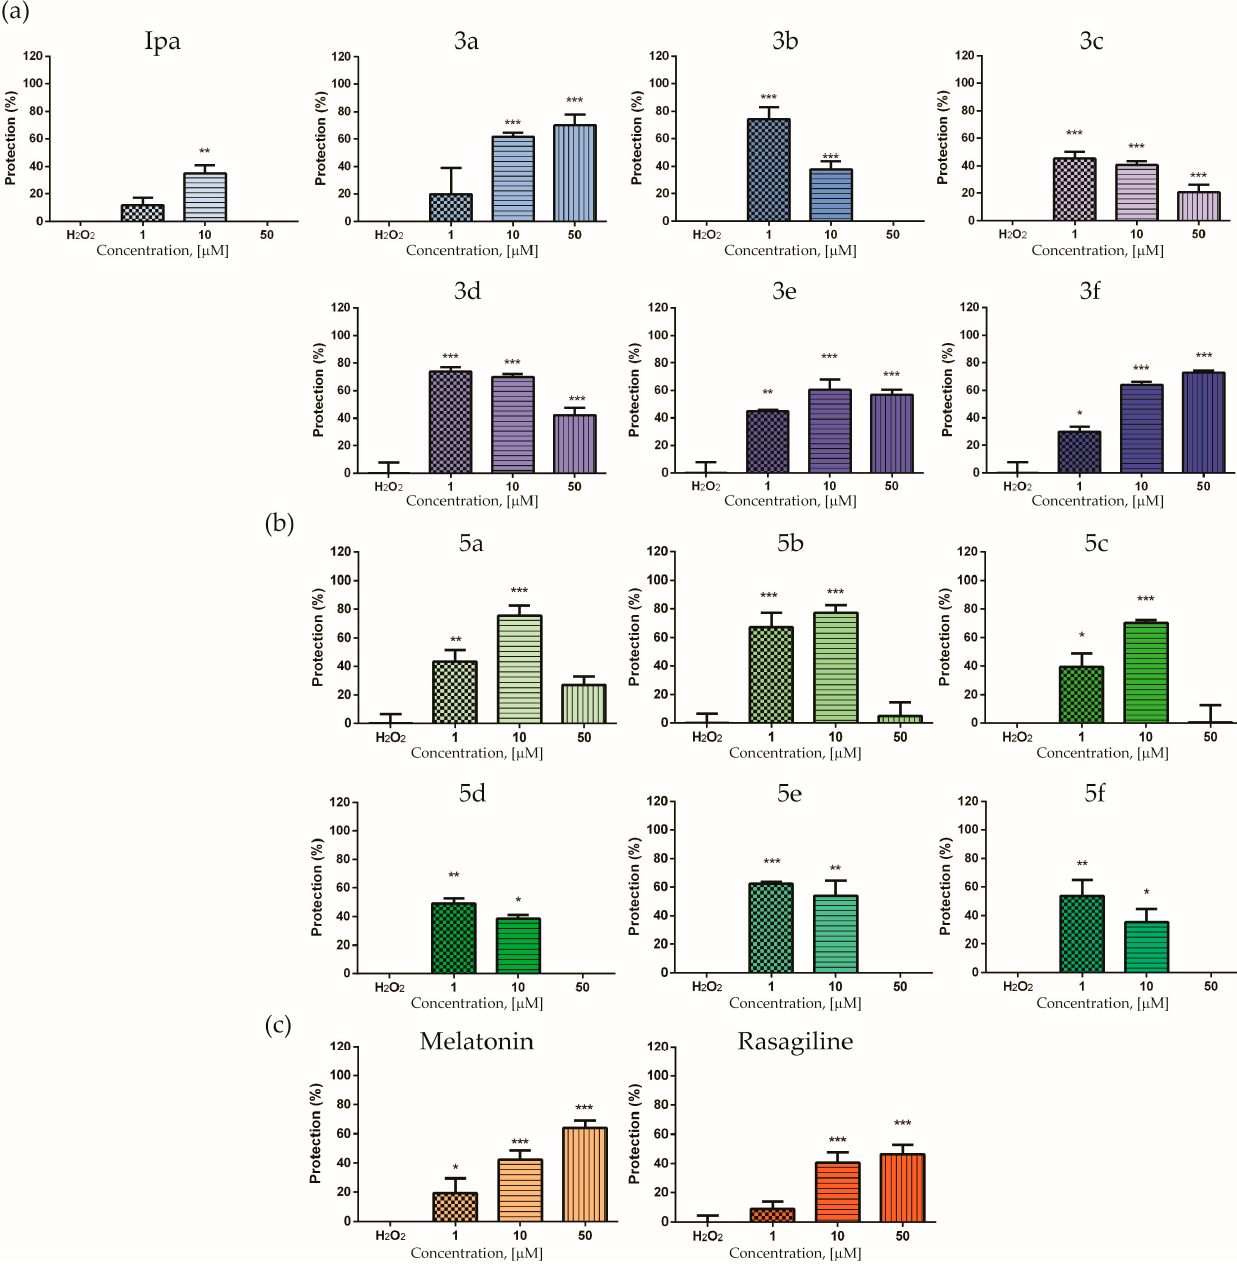
Figure 2. Protective effects of ( a ) IPA and compounds 3a–f ; ( b ) compounds 5a–f ; and ( c ) reference melatonin and rasagiline at different concentrations (1, 10, and 50 µ M), in a model of H 2 O 2 -induced oxidative stress in human neuroblastoma SH-SY5Y cells. Data are presented as means ± SEM of three independent experiments. * p < 0.05, ** p < 0.01, *** p < 0.001, vs. H 2 O 2 -treated cells (one-way analysis of variance with Dunnet’s post hoc test).